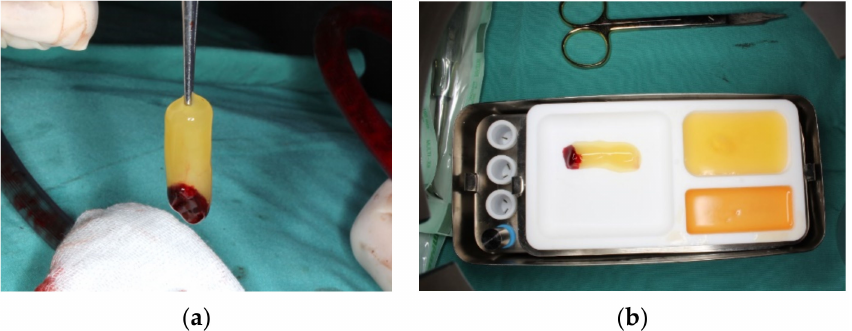
Figure 3. ( a ) The PRF clot removed from the tube with a tweezer; ( b ) the PRF clot pressed to obtain a resistant fibrin